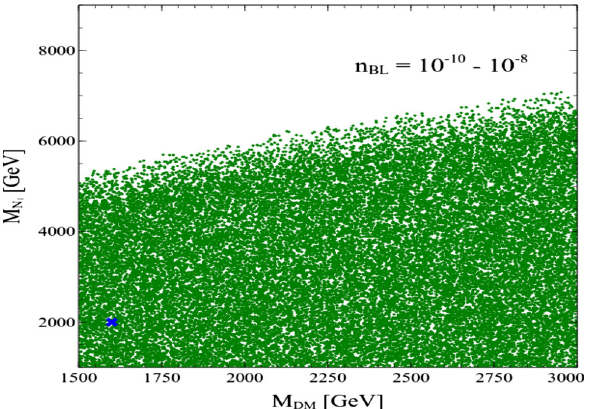
Fig. 16 Allowed region in the M DM – M N observedDMrelicdensity.Thebluecolouredstarrepresentsourbench- mark point ( M DM = 1600 GeV, M N